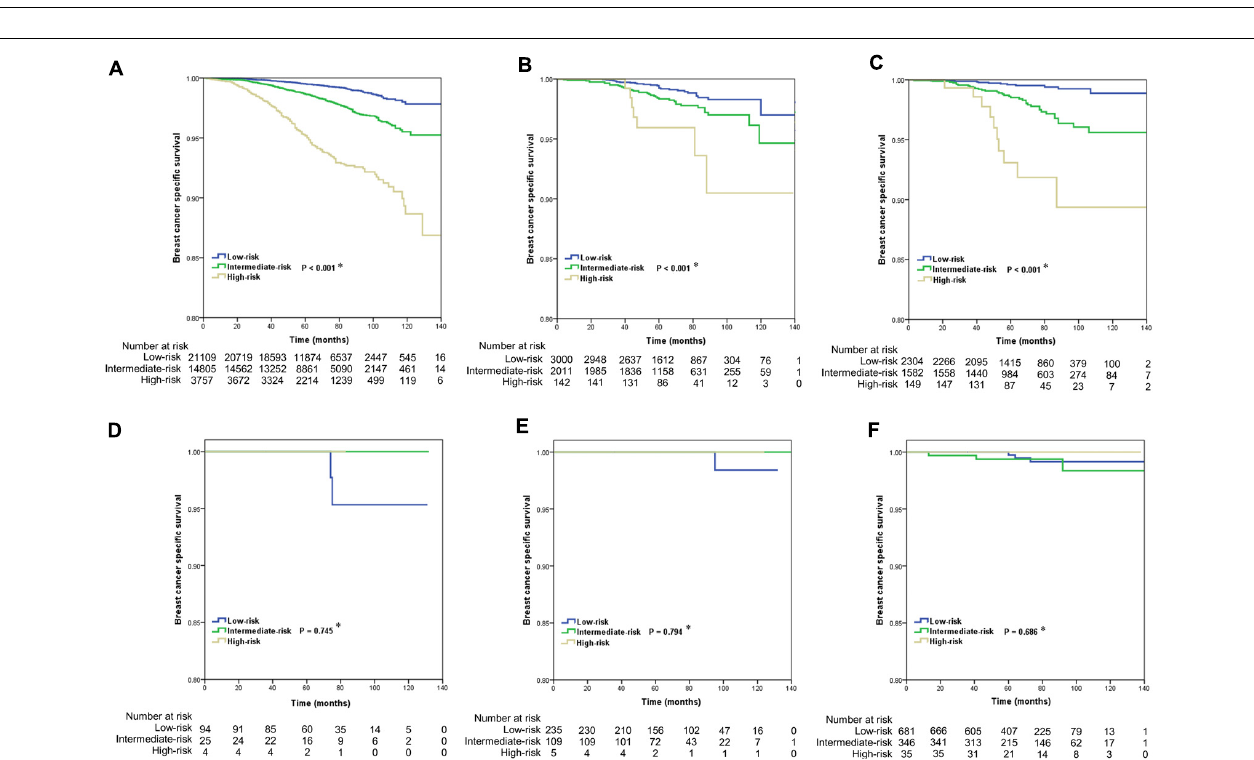
FIGURE 3 | Kaplan-Meier curves of the effect of 21-gene recurrence score on breast cancer specific survival by histologic subtypes of breast cancer ( A , IDC NOS; B , lobular carcinoma NOS; C , IDC-L; D , cribriform carcinoma NOS; E , tubular adenocarcinoma; F , mucinous adenocarcinoma) ( ∗ low-risk vs. intermediate-risk vs.